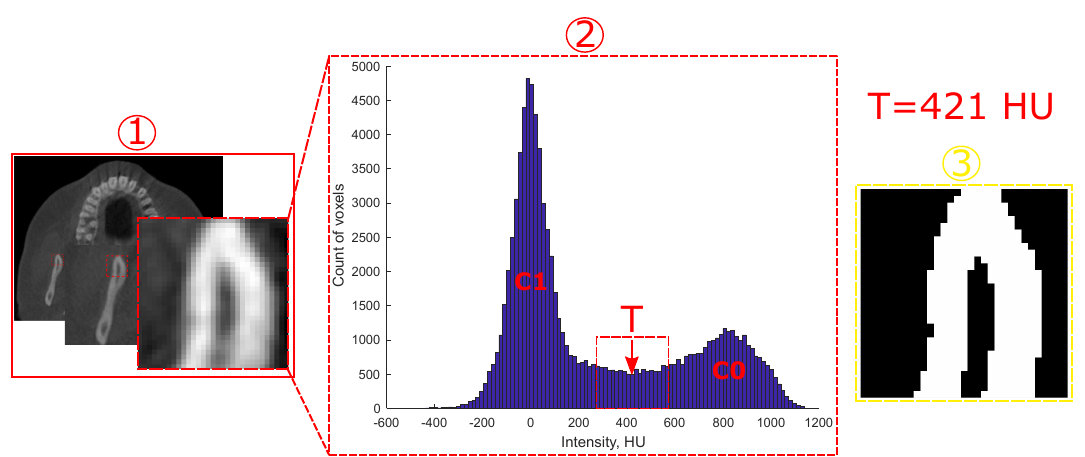
Figure 4. Analysing histogram ( 2 ) in selected sliding window volume ( 1 ) in order to find an optimal threshold T to segmented a bone ( 3 ).